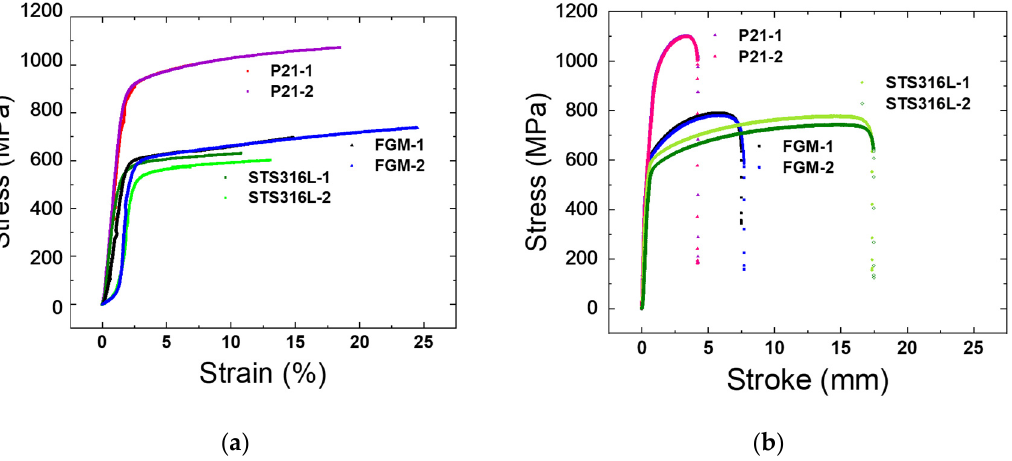
Figure 15. Tensile test curves of P21, STS316L and FGM: ( a ) stress–strain curves; ( b ) stress–stroke curves.